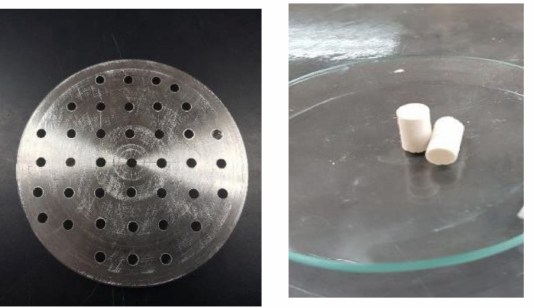
Figure 1. Stainless-steel mold and cement (6 mm diameter and 12 mm